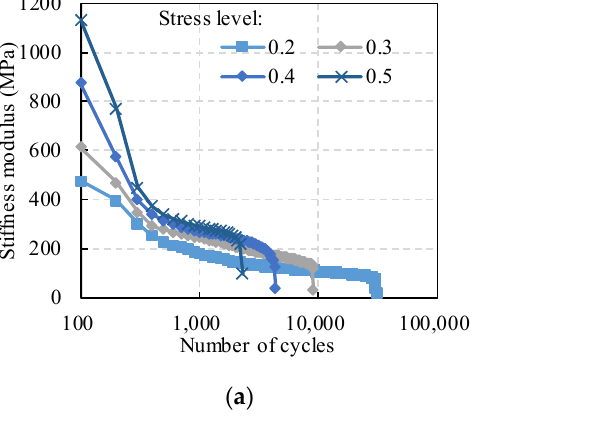
Figure 4. Stiffness modulus of SCB fatigue test: ( a ) changes of ER–PC with cycle number; ( b ) Average modulus of ER–PC and PU–PC.